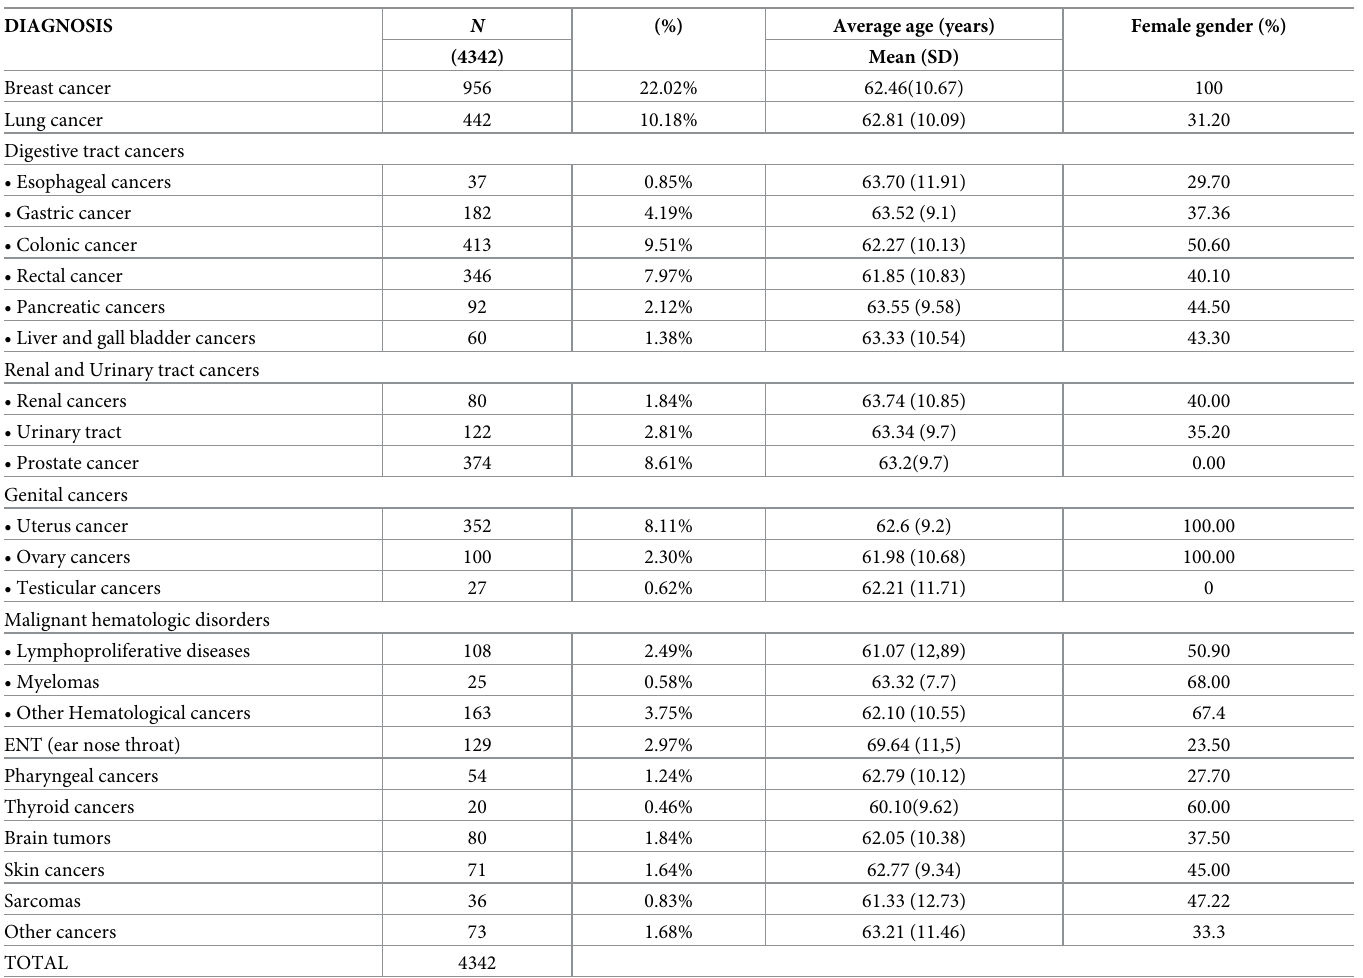
Table 1. Prevalence of cancer types/groups in the assessed data base.